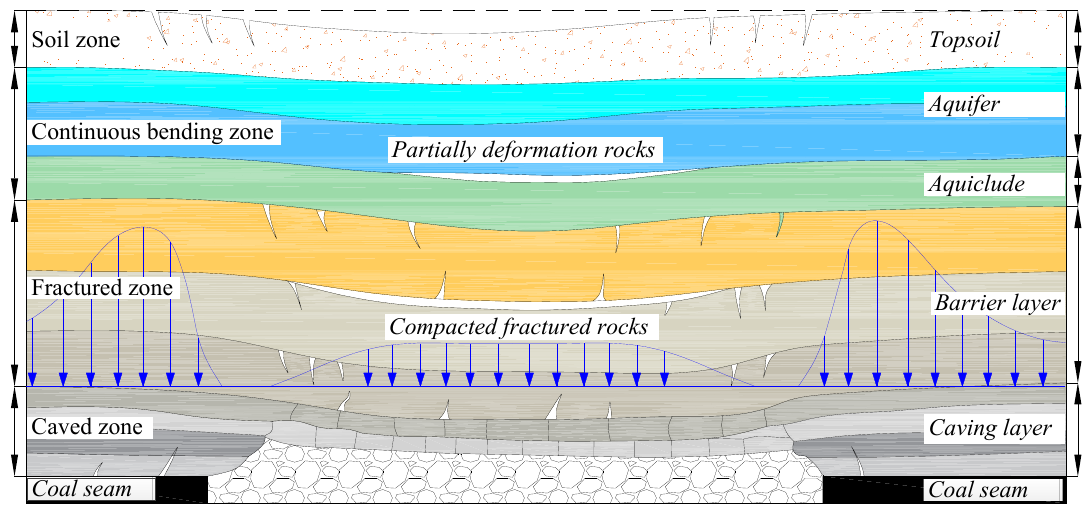
Figure 1. Overburden movement resulting from longwall mining.